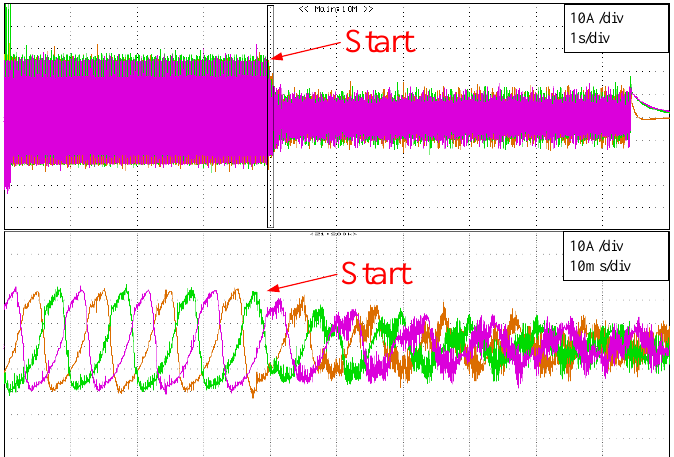
Figure 22. Circulating current with resonant controllers.